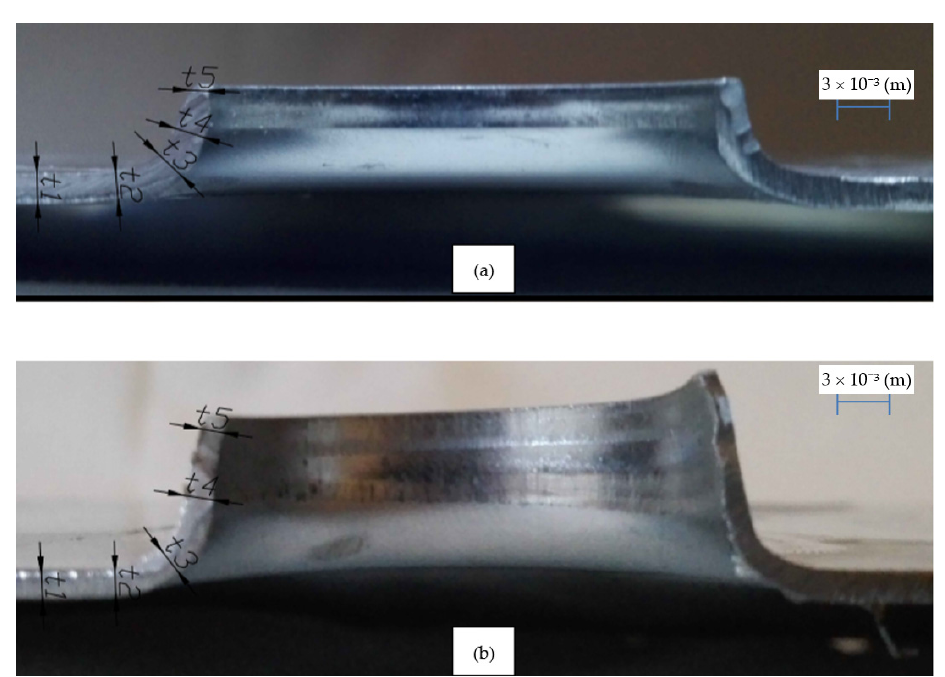
Figure 15. Examples of test samples after the flange extrusion process along with the indicated measurement areas for: h6 model ( a ) and h10 model ( b ).